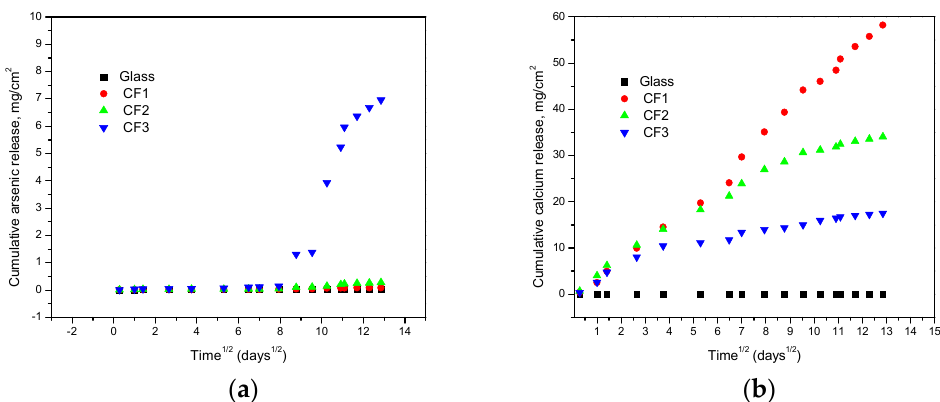
Figure 6. Variation of cumulative ( a ) arsenic and ( b ) calcium with leaching time.